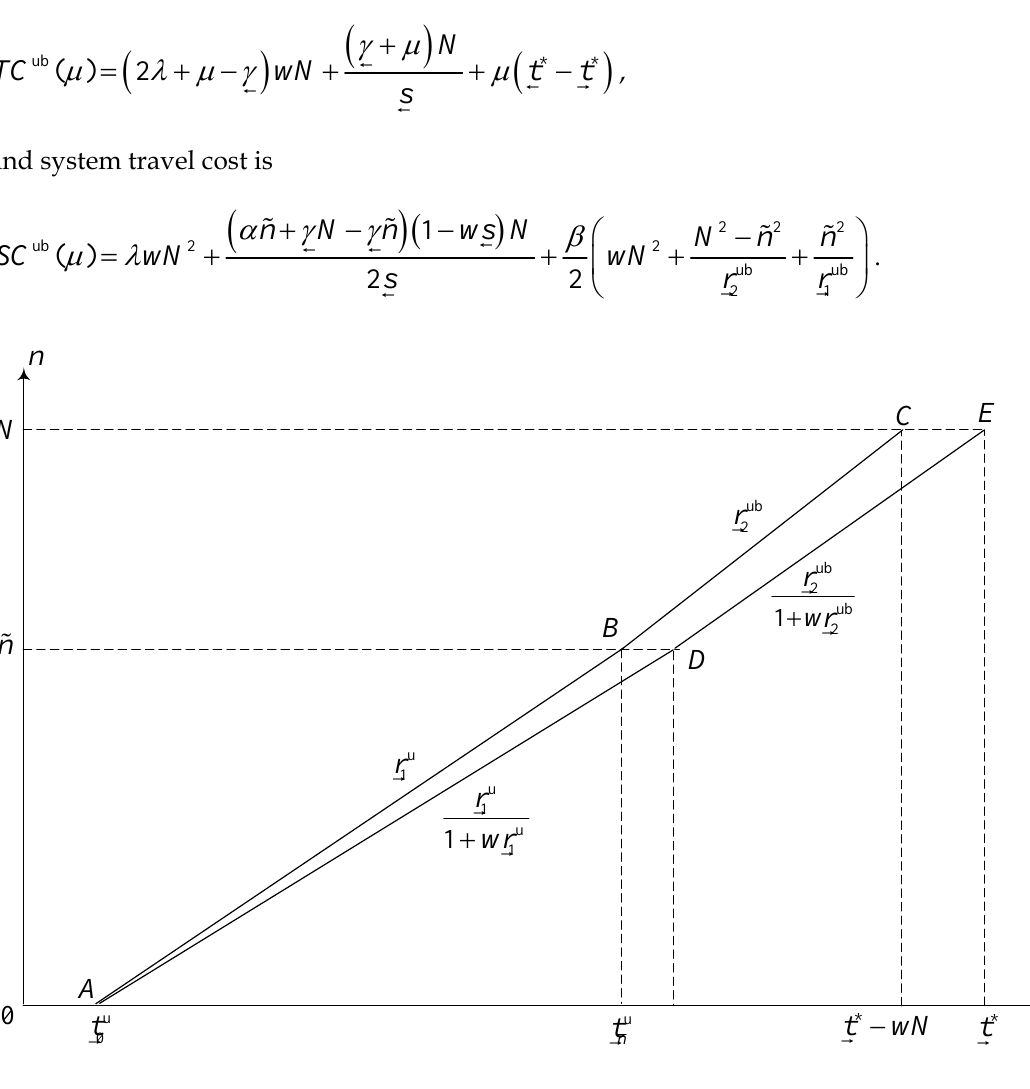
The departure curves in the morning also follow a pattern similar to Zhang et al.(2008)’s regime f, but with different departure rates. Note that in the morning rush hour, the traffic pattern follows Wardrop’s user equilibrium, since everyone has an equal travel cost and no one can reduce her/his travel cost by unilaterally changing commuting